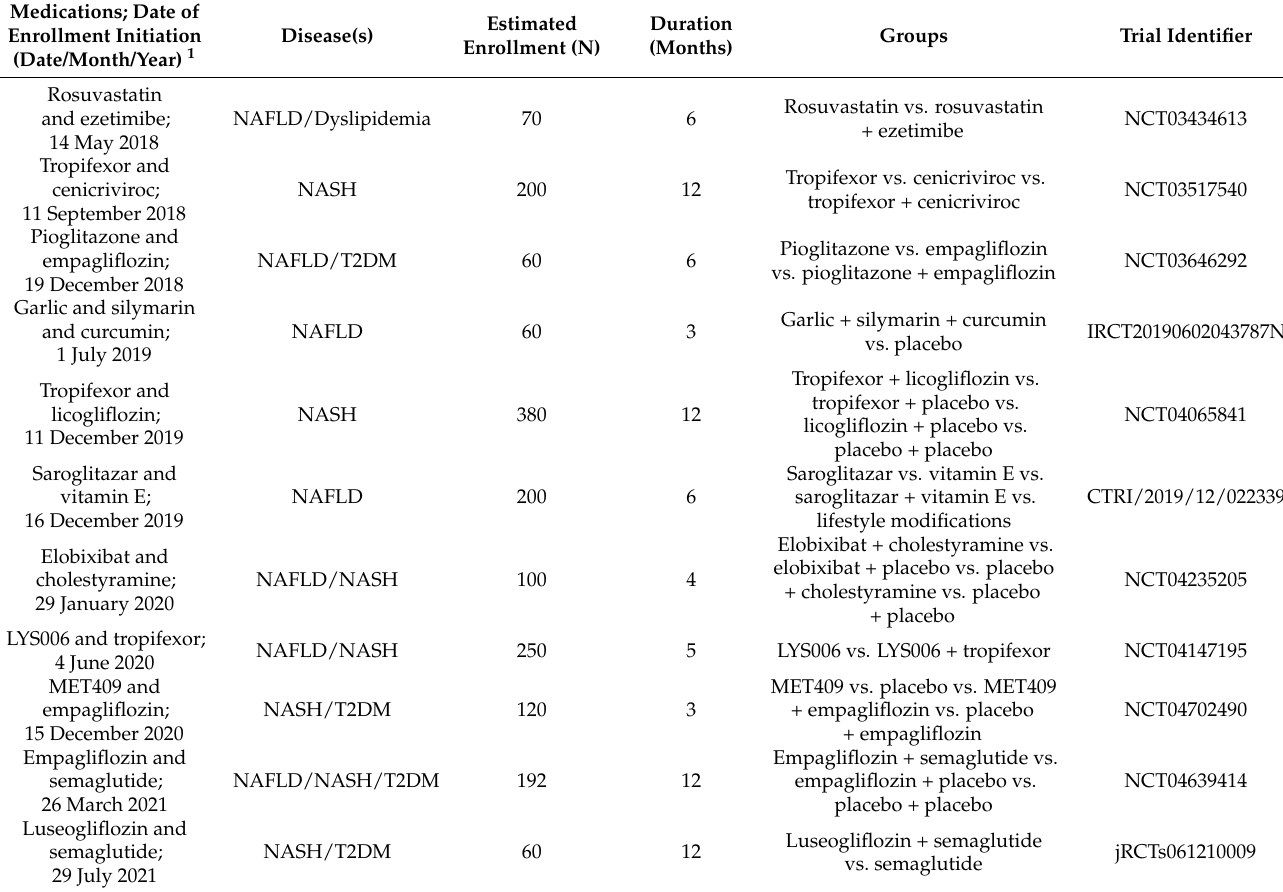
Table 2. Ongoing RCTs evaluating combination therapies in patients with